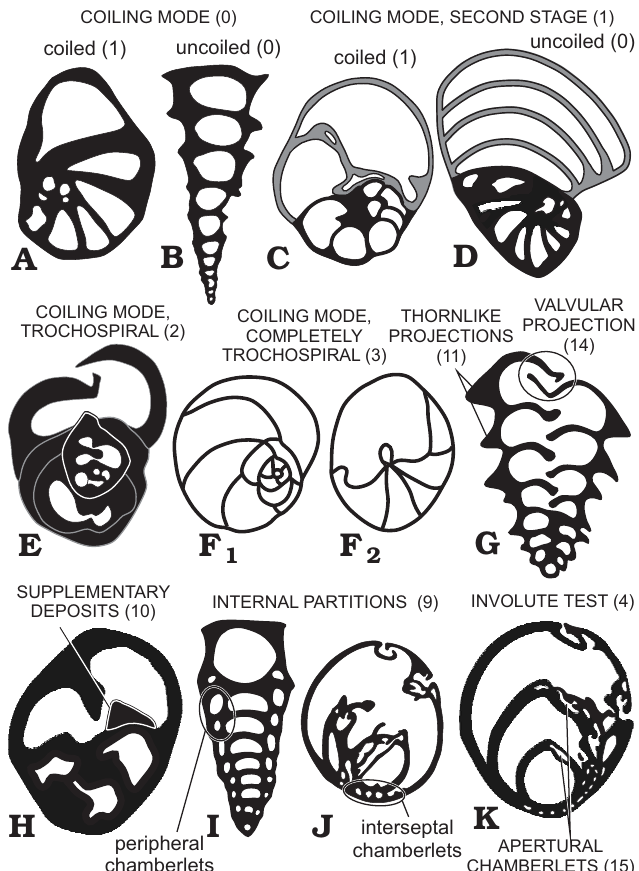
Fig. 1. Graphic explanation of descriptive morphological characters on which the cladistic analysis is based. A . Charliella rossae Alt ı ner